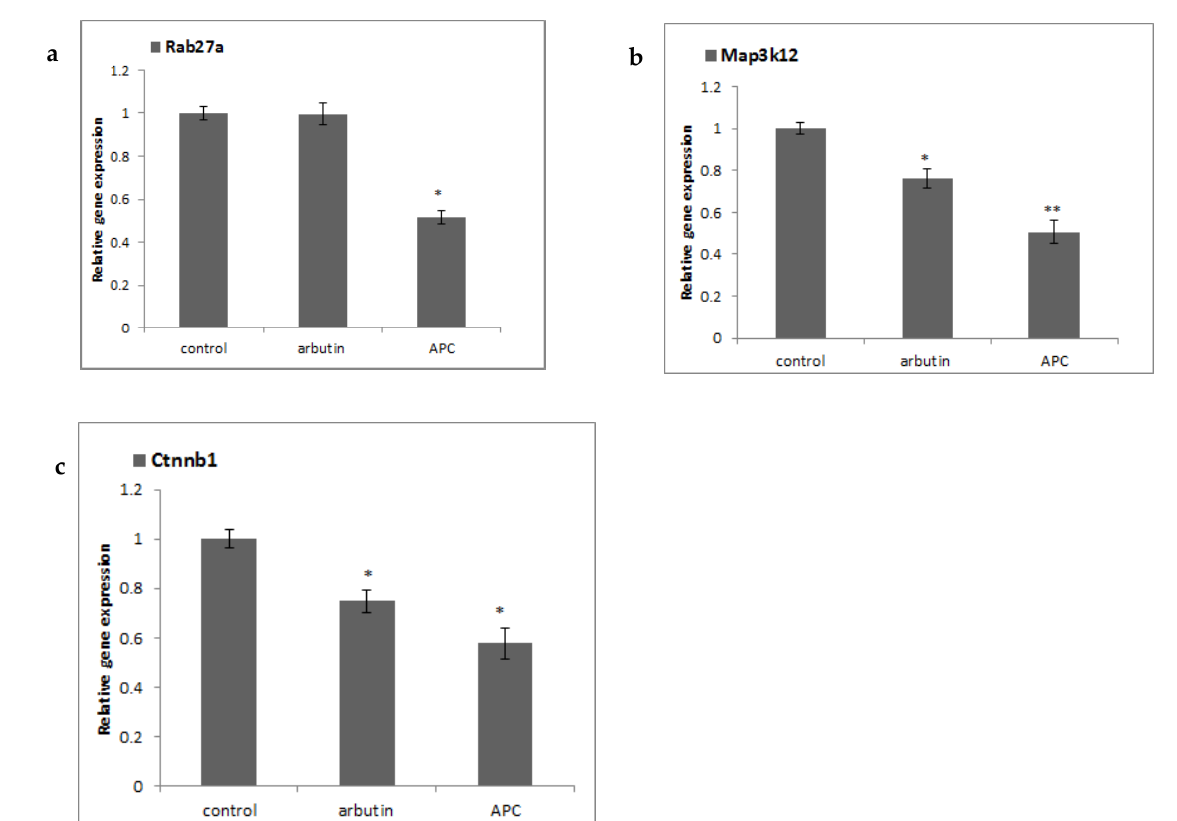
Figure 2. Effect of argan press-cake (APC) on the expression of ( a ) Rab27a (member RAS oncogene family), ( b ) mitogen- activated protein kinase kinase kinase 12 ( Map3k12 ), and ( c ) catenin (cadherin associated protein) beta1 ( Ctnnb1 ) genes in B16 cells. Cells were seeded onto a 100-mm dish at a density of 3 × 10 6 . B16 cells were treated with or without arbutin (100 µM) or argan press-cake extract (50 µg/mL) for 24 h. Rt-PCR was used to determine the select genes expression level. Data are expressed as mean ± SD ( n = 3), * p < 0.05, ** p < 0.01.